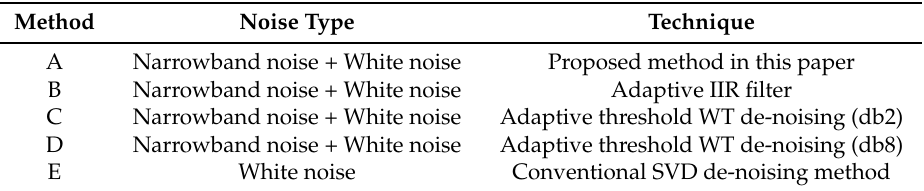
Table 3. Conventional de-noising